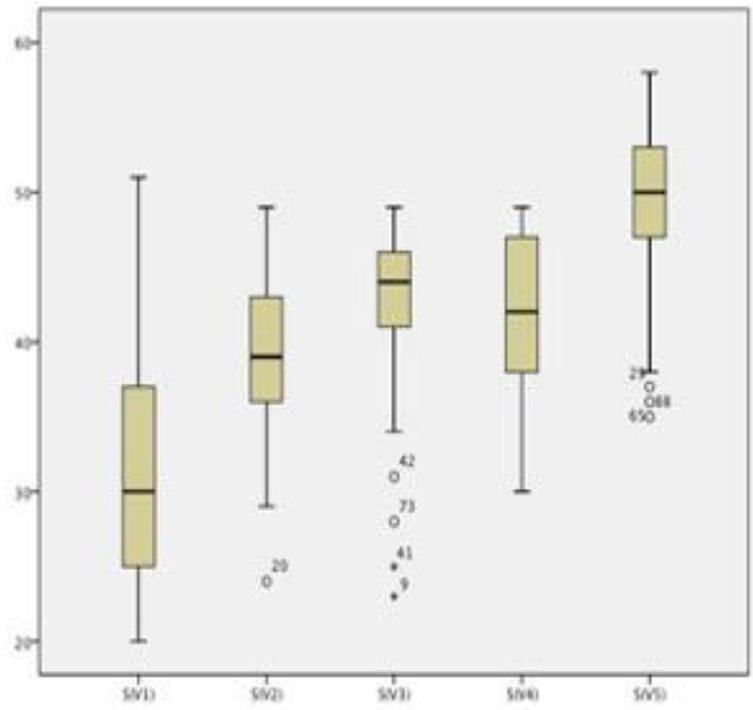
Figure 3 - Scores in end-to-end venous anastomosis sessions. The box plots show the distribution of scores in end-to-end venous anastomosis sessions. A gradual increase was observed ( p o 0.05).